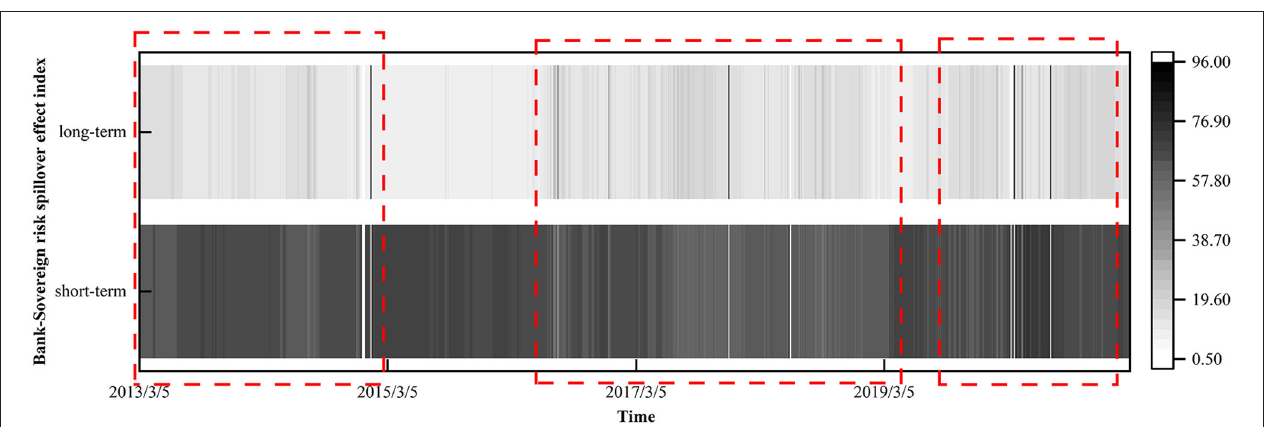
FIGURE 6 | Long-term and short-term spillover index heat map of bank risk and sovereign